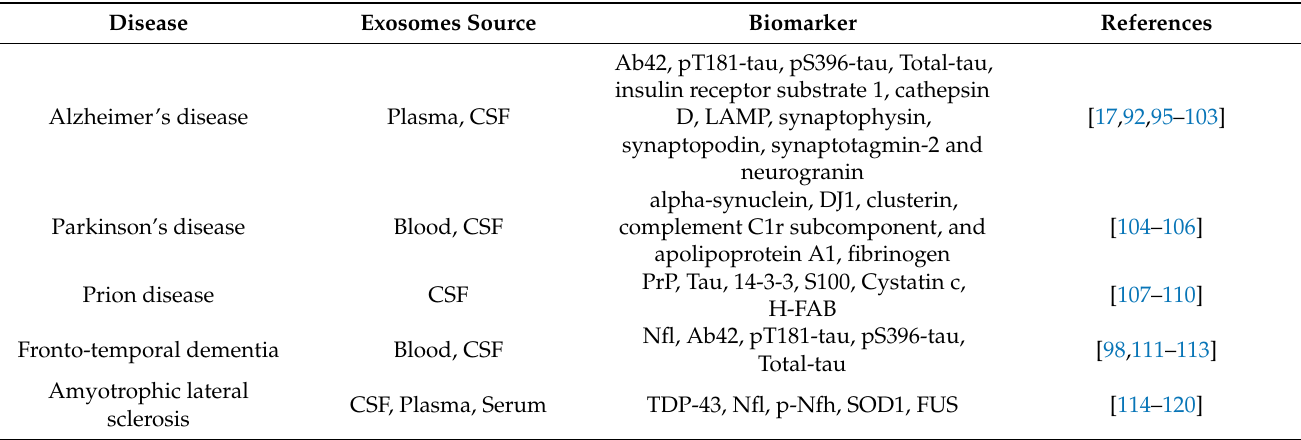
Table 2. Exosomal protein biomarkers for CNS